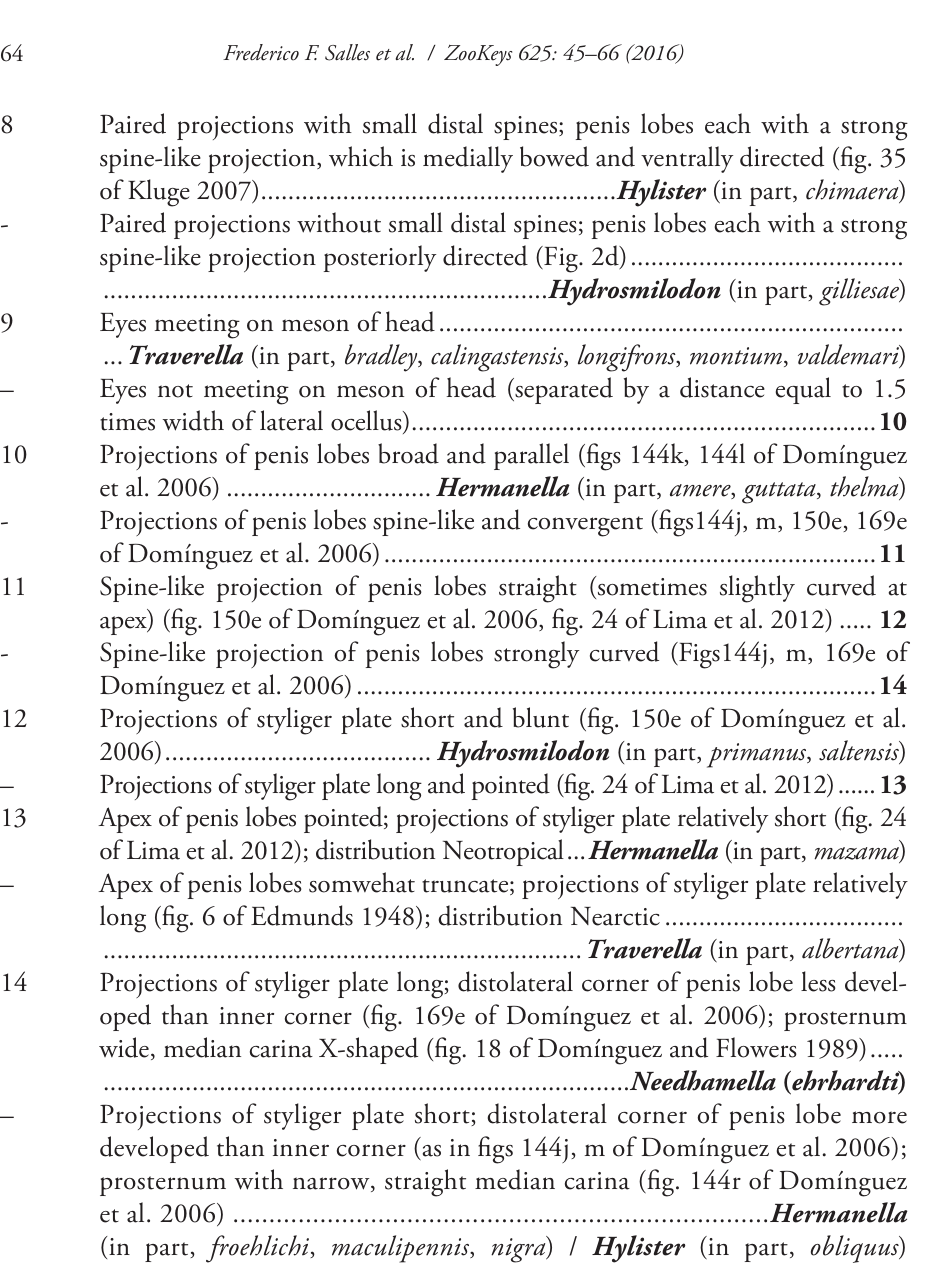
Paired projections with small distal spines; penis lobes each with a strong spine-like projection, which is medially bowed and ventrally directed (fig. 35 - Paired projections without small distal spines; penis lobes each with a strong spine-like projection posteriorly directed (Fig. 2d) ........................................